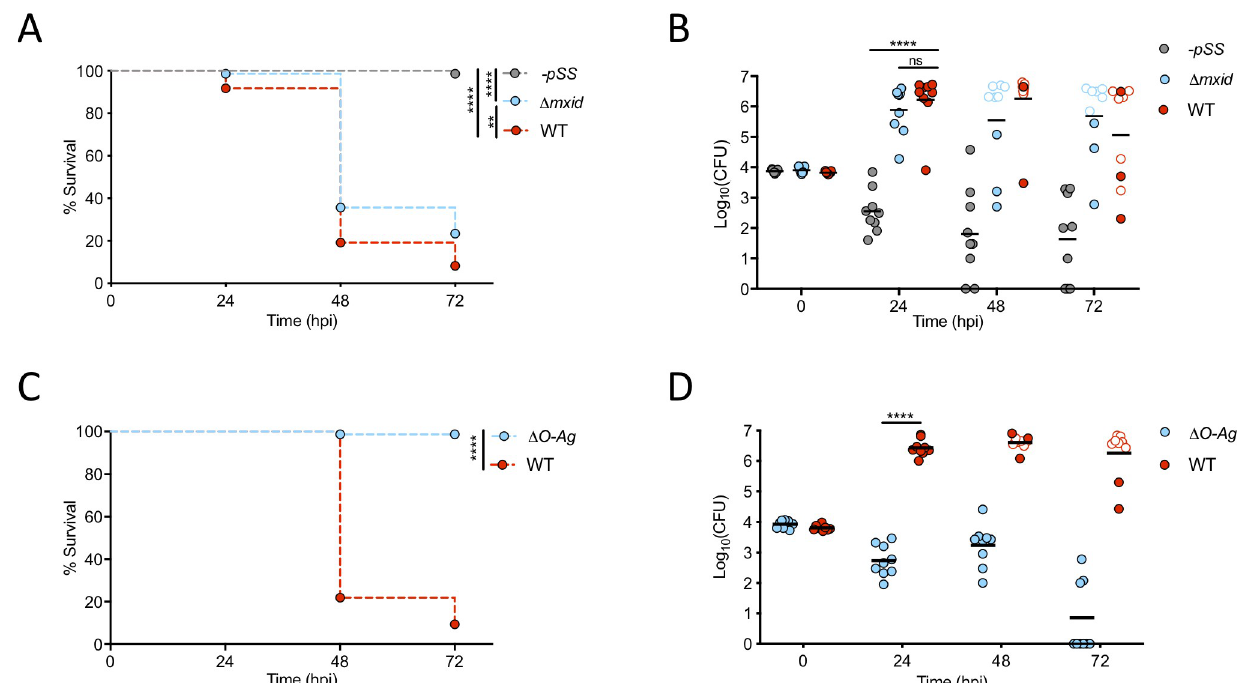
Fig 3. S . sonnei virulence depends on its O-antigen. A,B. Virulence of S . sonnei depends on its virulence plasmid . Survival curves (A) and Log 10 - transformed CFU counts (B) of larvae injected in the HBV with S . sonnei -pSS (grey), Δ mxid (blue) or WT (red) strains. Experiments are cumulative of 3 biological replicates. In B, full symbols represent live larvae and empty symbols represent larvae that at the plating timepoint had died within the last 16 hours. Statistics: Log-rank (Mantel-Cox) test (A); one-way ANOVA with Sidak’s correction on Log 10 -transformed data (B); ns, non-significant; �� p < 0.0021; ���� p < 0.0001. See also S3H–S3K Fig for experiments at 32.5˚C. C,D. Virulence of S . sonnei depends on its O-antigen. Survival curves (C) and Log 10 -transformed CFU counts (D) of larvae injected in the HBV with S . sonnei Δ O-Ag (blue) or WT (red) strains. Experiments are cumulative of 3 biological replicates. In D, full symbols represent live larvae and empty symbols represent larvae that at the plating timepoint had died within the last 16 hours. Statistics: Log-rank (Mantel-Cox) test (C); unpaired t-test on Log 10 -transformed data (D); ���� p < 0.0001. See also S3H–S3K Fig for experiments at 32.5˚C.